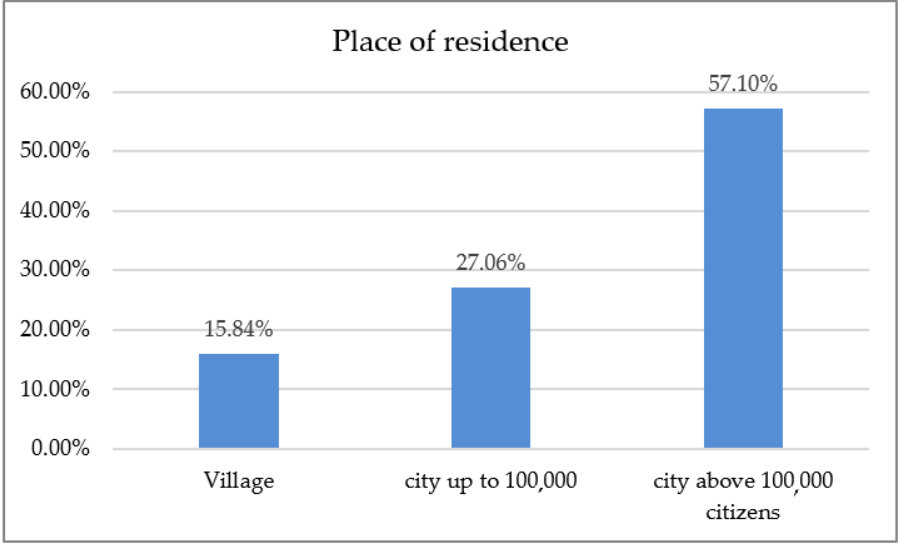
Figure 1. Place of Figure 1. Place of residence. Table 1. The profile of performed procedures.